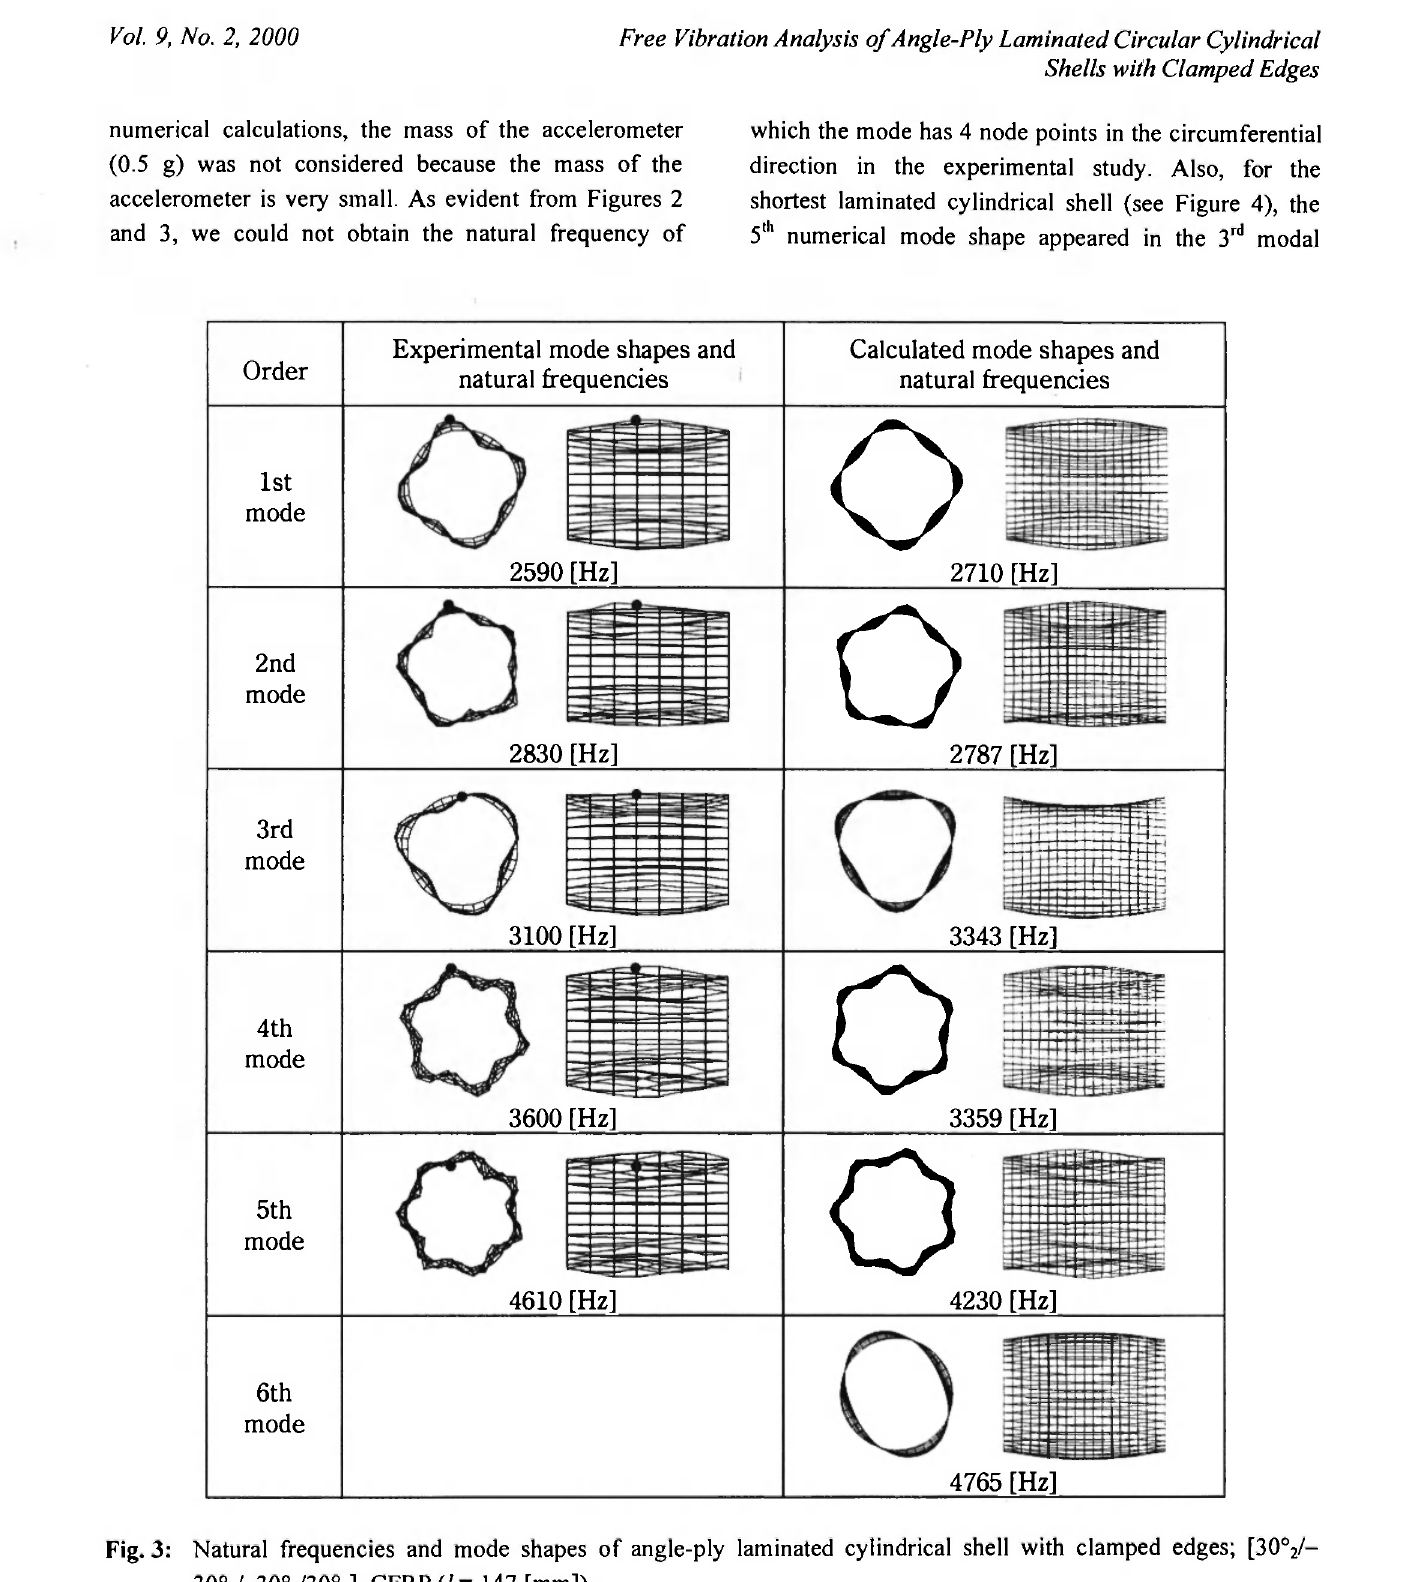
Fig. 3: Natural frequencies and mode shapes of angle-ply laminated cylindrical shell with clamped edges; [30° 2 /- 30° 2 /-30 O 2 /30 O 2 ],CFRP(/= 147 [ mm